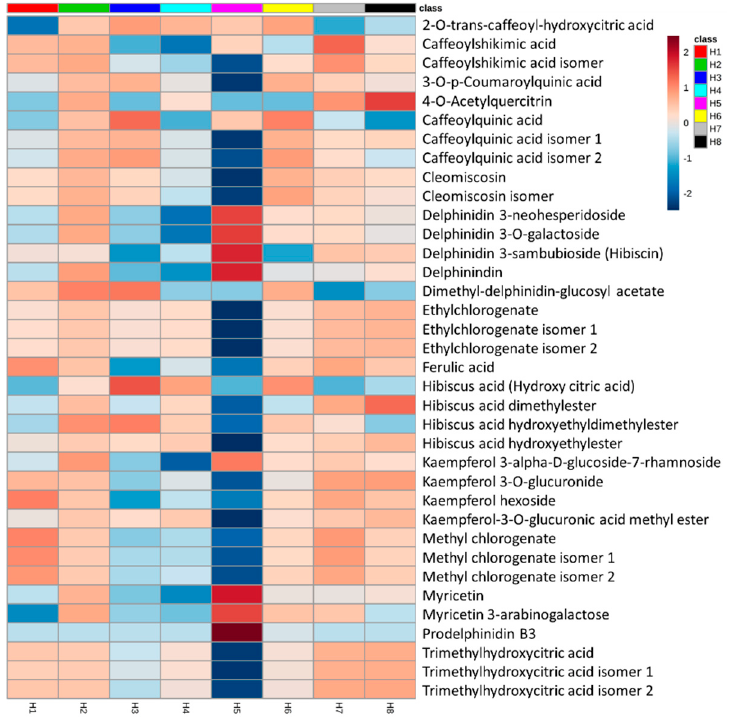
Figure 5. Heat map for the distribution of metabolites identified from Hibiscus extracts. The average metabolite abundance from five biological replicates was used for the generation of heat maps. H1: 1% HCl in methanol, H2: 80% methanol, H3: 100% water, H4: 1% HCl in water, H5: 70% ethanol, H6: 50% methanol, H7: methanol and H8: 1% HCl in 70% ethanol.